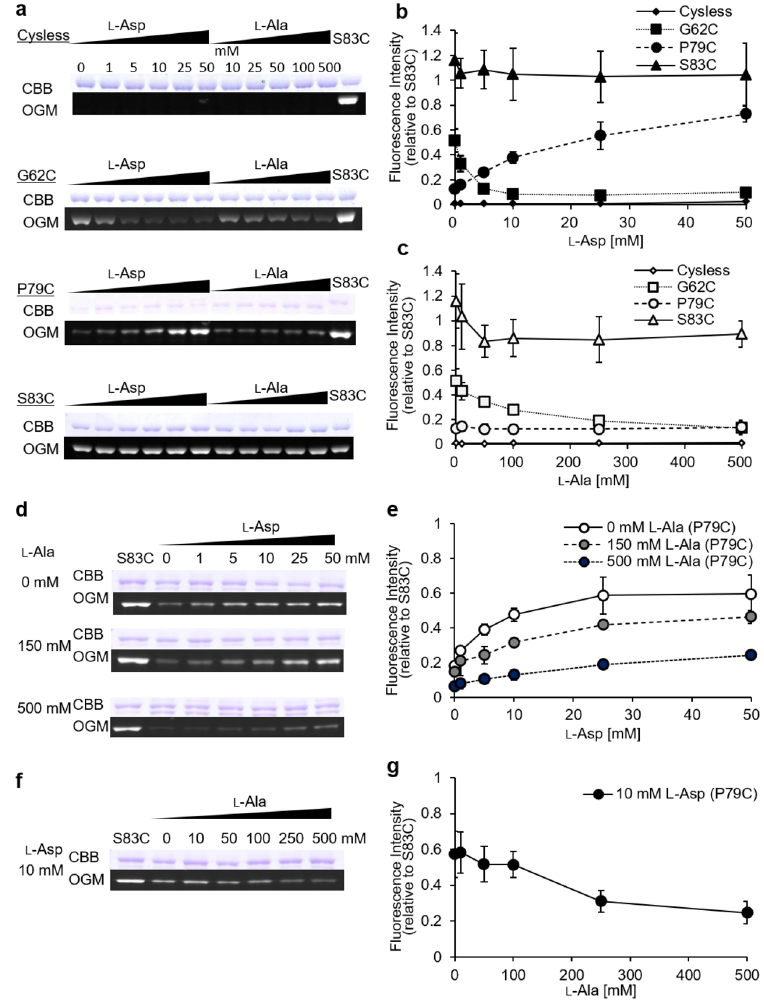
Figure 1. Substrate concentration dependence of OGM labelling efficiency. Membrane ghosts of each variant were exposed to OGM in the absence or presence of various concentrations of l-Asp or l-Ala before protein solubilization and purification. Purified samples were analyzed by using non-reducing SDS-PAGE (10% polyacrylamide gel matrix). ( a ) A single gel containing all of the samples was used to record the fluorescence signal with an LAS-4000 imaging system (bottom panel) before the gel was stained with CBB to visualize protein (upper panel). ( b , c ) Levels of fluorescence intensity and CBB staining under non-reducing SDS-PAGE were normalized against the corresponding levels of the S83C variant. The labeling efficiency of cysteine in each variant (Cysless, ♦ in b or ◊ in c ; G62C, ■ in b or □ in c ; P79C, ● in b or ○ in c ; S83C, ▲ in b or Δ in c ) is shown as a ratio of the normalized level of fluorescence intensity and CBB staining ( b , presence of l-Asp; c , presence of l-Ala). ( d – g ) Inhibition effects of two native substrates on OGM labeling. P79C was OGM labeled under conditions in which two native substrates were present. E. coli cells that expressed P79C were exposed to OGM in the presence of ( d and e ) various concentrations of l-Asp with fixed l-Ala concentrations (0 mM, ○ ; 150 mM, gray dot ● ; 500 mM, ● ) or ( f and g ) various concentrations of l-Ala with fixed l-Asp concentration (10 mM, ● ). The original gels are presented in Supplementary information Fig.